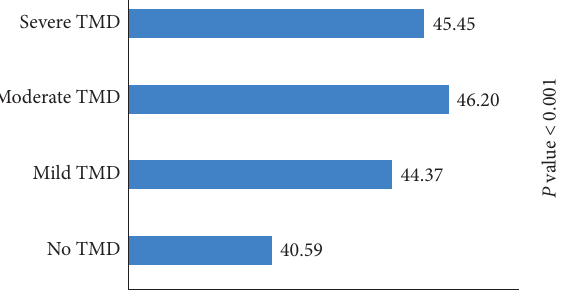
Figure 1: Comparison of mean test anxiety score in different categories of